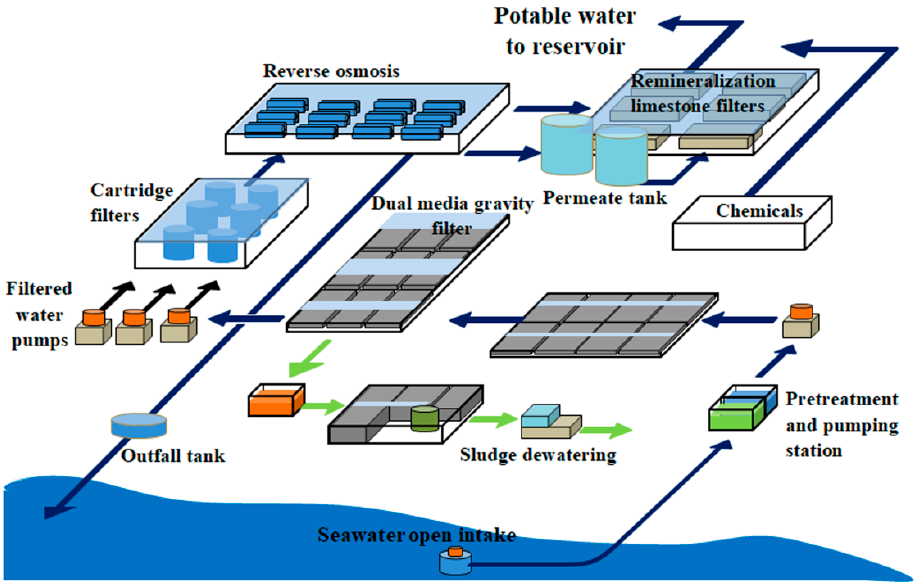
Figure 2. Schematic diagram of Barka IV desalination plant.